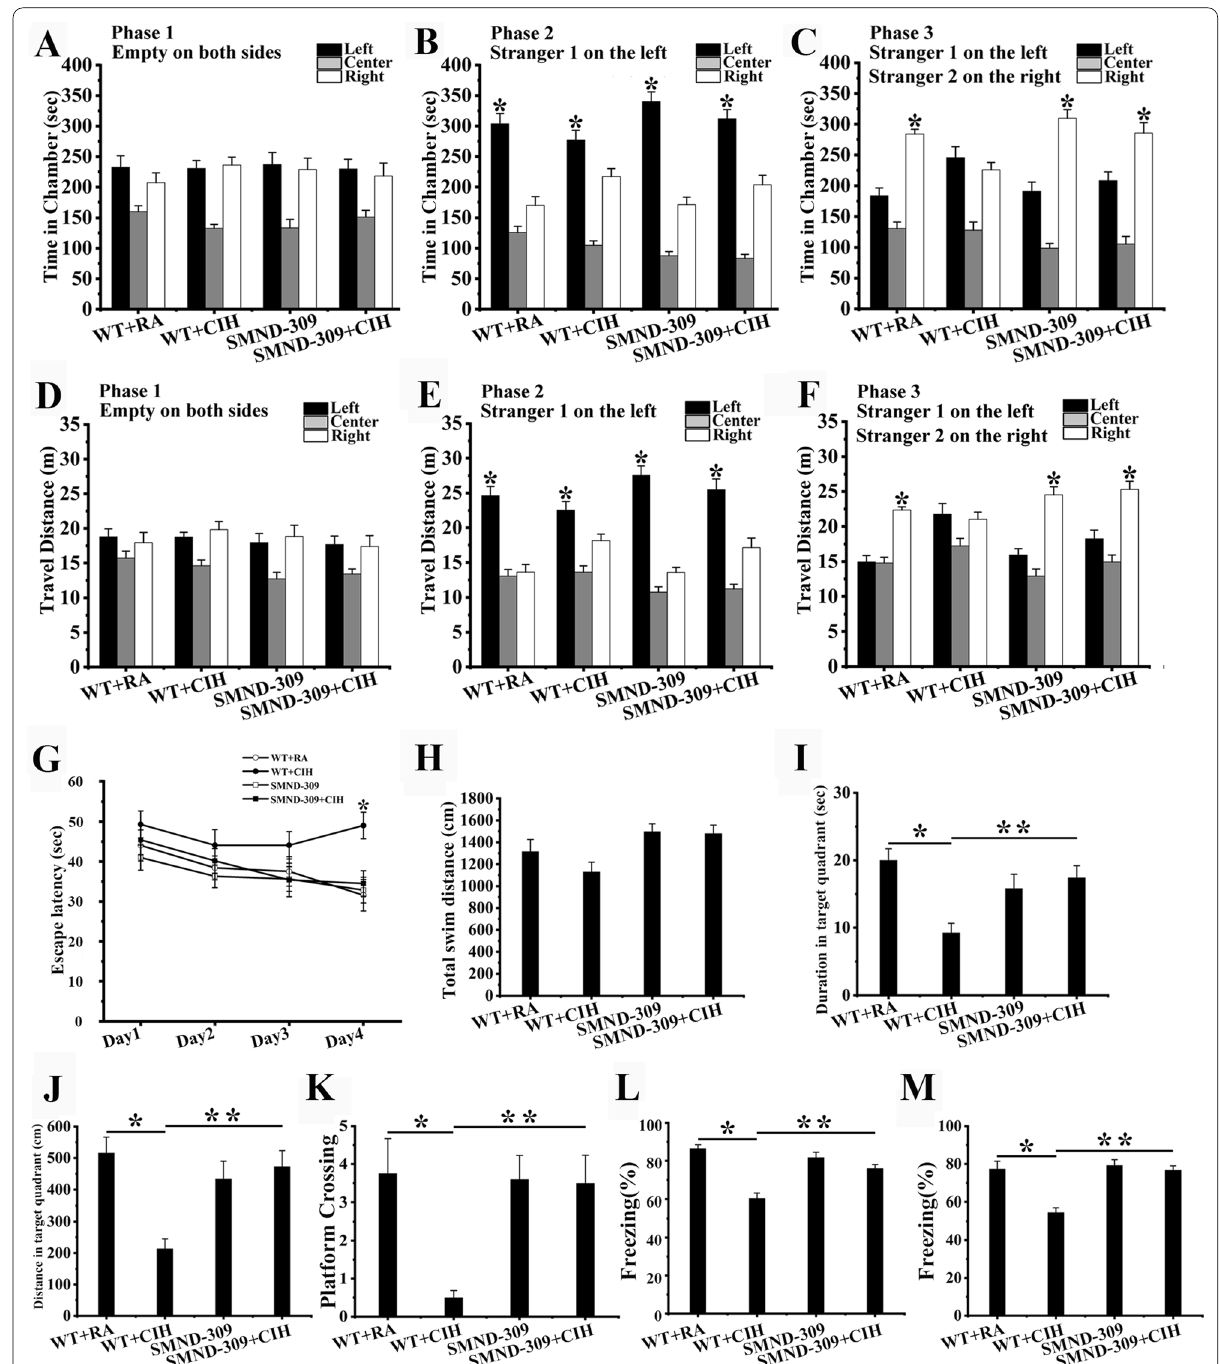
Fig. 2 (See legend on previous